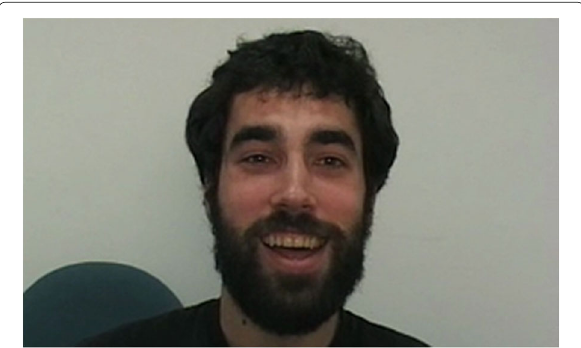
Fig. 5 A video frame from MAHNOB Laughter data set. A video